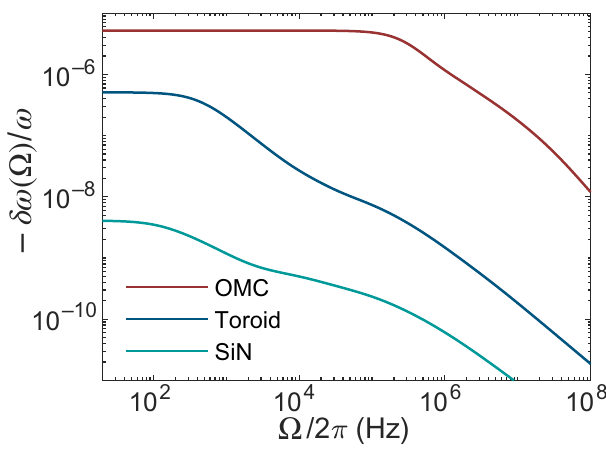
FIG. 7. Simulated cavity frequency response of different microcavities from finite-element simulations at room temper- ature, including a silicon OMC [30], silica microtoroid [72], and SiN ring resonator [8]. The detailed parameters in the FEM simulation are listed in Table II.